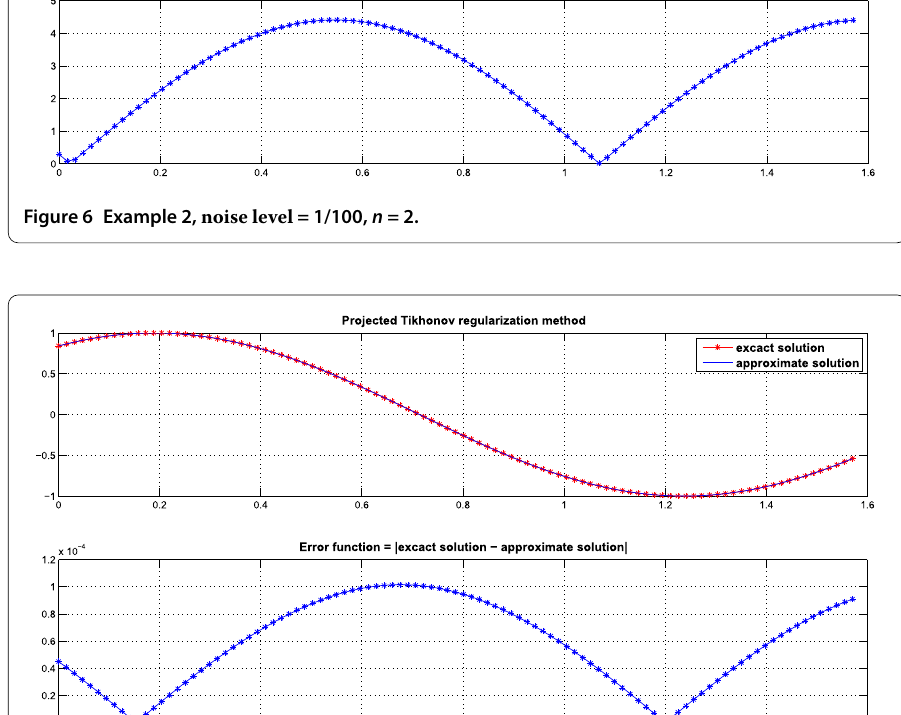
Figure 7 Example 2, noise level = 1/1,000, n =